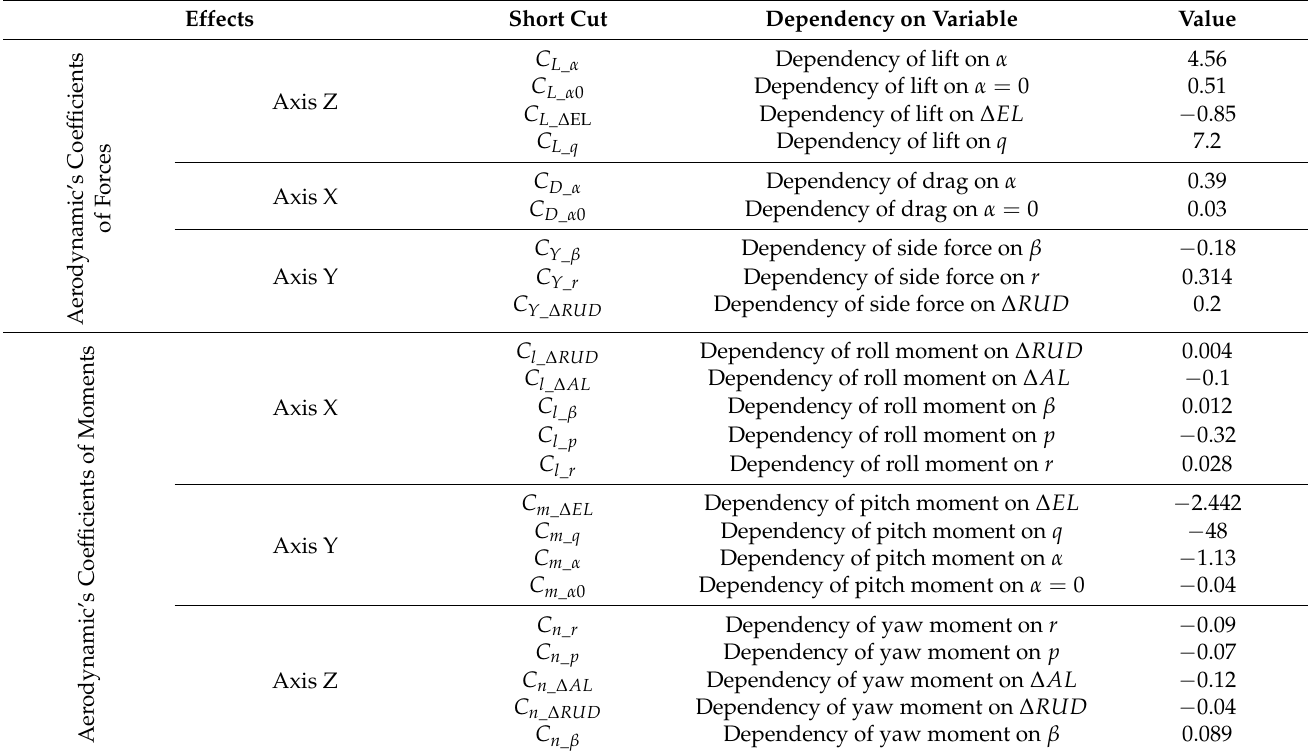
Table 2. “SkyDog” aerodynamic coefficients.